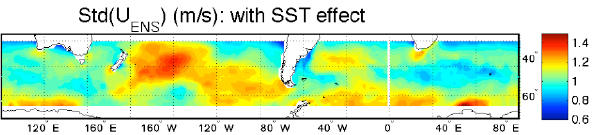
Figure 8. The standard deviation of the wind speed time series obtained by taking the 2 Fig. 8. The standard deviation of the wind speed time series ob- ensemble average of 100 simulations of SST-dependent SLW model forced by the observed 3 tained by taking the ensemble average of 100 simulations of SST- history of SST anomalies.. The model was constructed in the phase space of 100 leading 4 dependent SLW model forced by the observed history of SST EOFs of SLW. A typical (maximum) standard deviation of analogous SLW-only model’s 5 anomalies. The model was constructed in the phase space of 100 ensemble-mean time series (not shown) is 0.25 (0.55) — both values are smaller than the 6 leading EOFs of SLW. A typical (maximum) standard deviation standard deviations shown here. 7 of analogous SLW-only model’s ensemble-mean time series (not shown) is 0.25 (0.55) – both values are smaller than the standard deviations shown here.